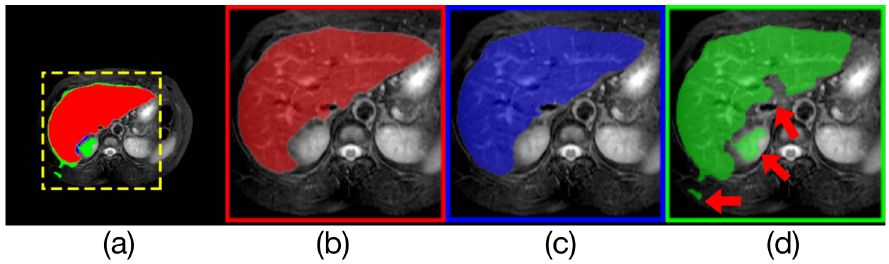
Figure 11. Comparison of model outputs and ground truth. ( a ) is composed of the other three figures above stacked from top to bottom, where the predicted extra areas are clearly seen. The red area in ( b ) is the manually annotated result. The blue region in ( c ) is the output of Render U-Net. The green region in ( d ) is the output of ANU-Net. Some areas with incorrect predictions are indicated with the red arrows in the figure.